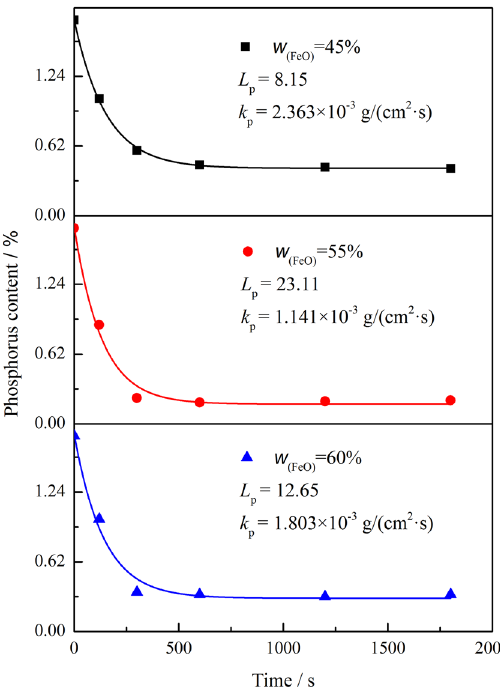
Figure 3: Fitting curves of the P content of the fi nal iron sample as a function of time with Al 2 O 3 content ranging from 4 to